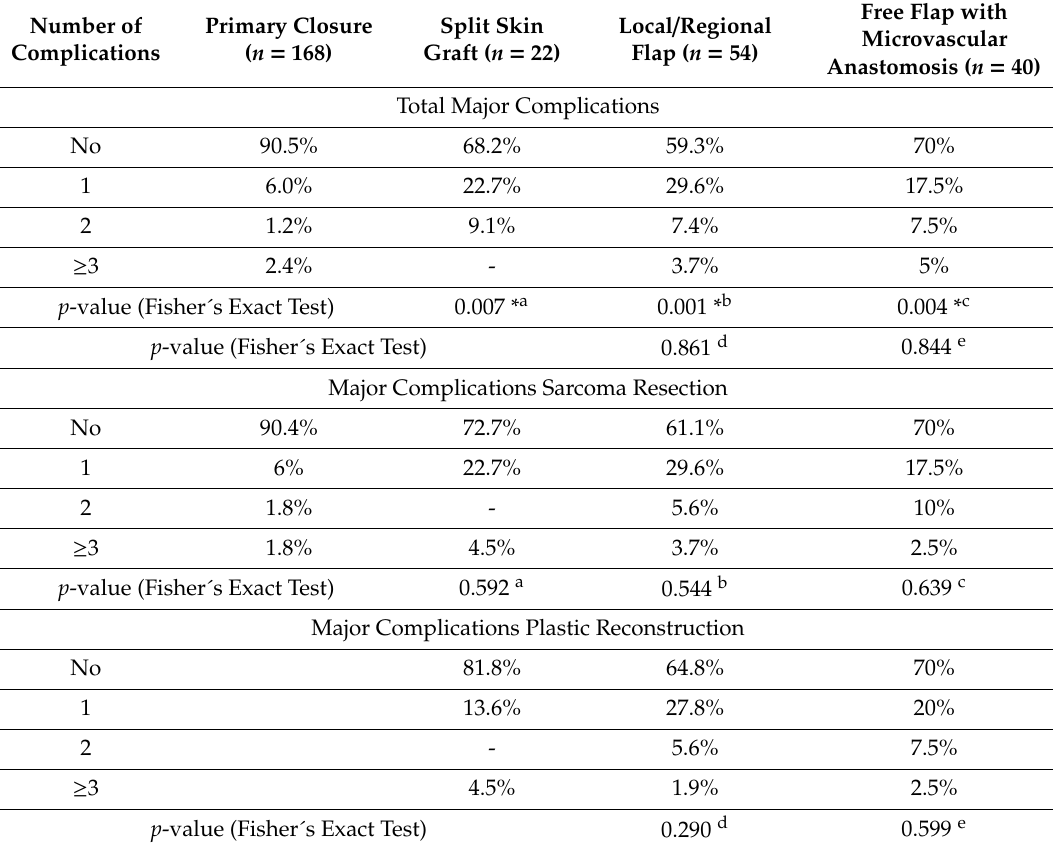
Table 5. Analysis of the rates of major complications. Major complications after plastic reconstruction are defined as complications that are directly linked to plastic reconstruction; major complications of sarcoma resection are defined as complications that are not linked to plastic reconstruction; and total major complications are defined as the sum of the two. * indicates statistical significance ( p ≤ 0.05). flap vs. primary closure; d local / regional flap vs. group of split skin graft; e free flap vs. group of split skin